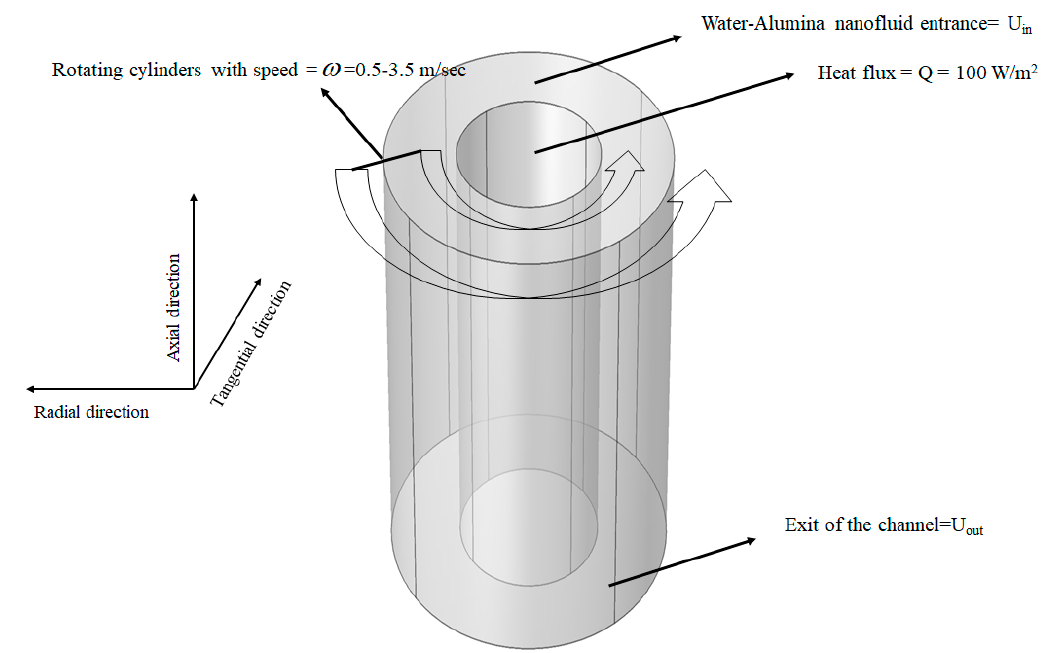
Figure 1. A view of the 3-dimensional, vertically settled annular parallel to the axial direction.